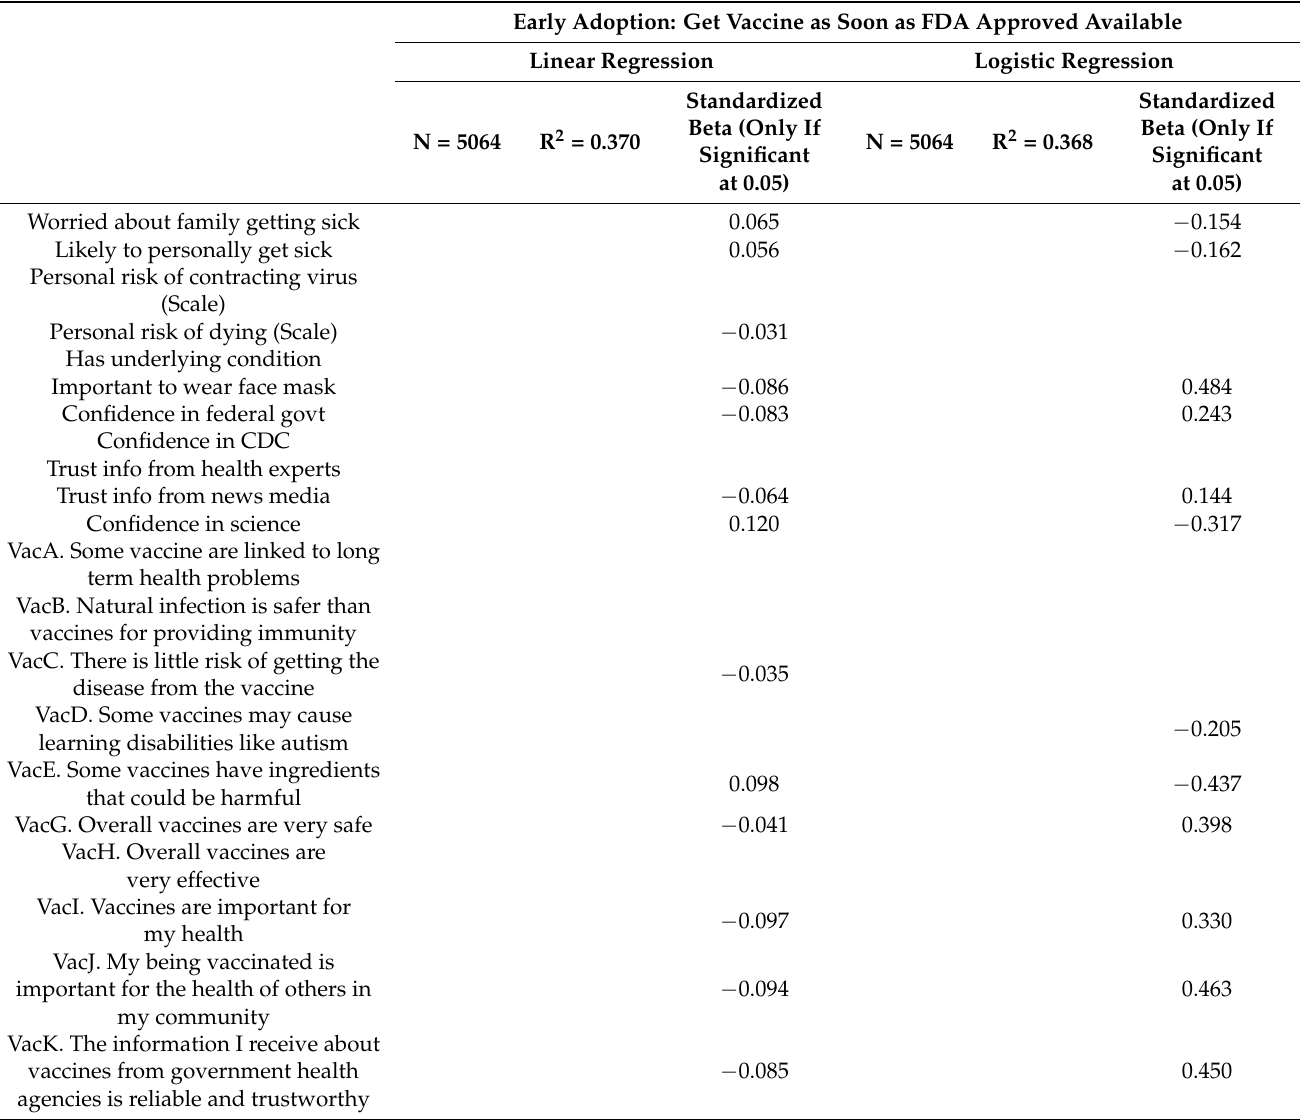
Table A5. Cont. Early Adoption: Get Vaccine as Soon as FDA Approved Available Linear